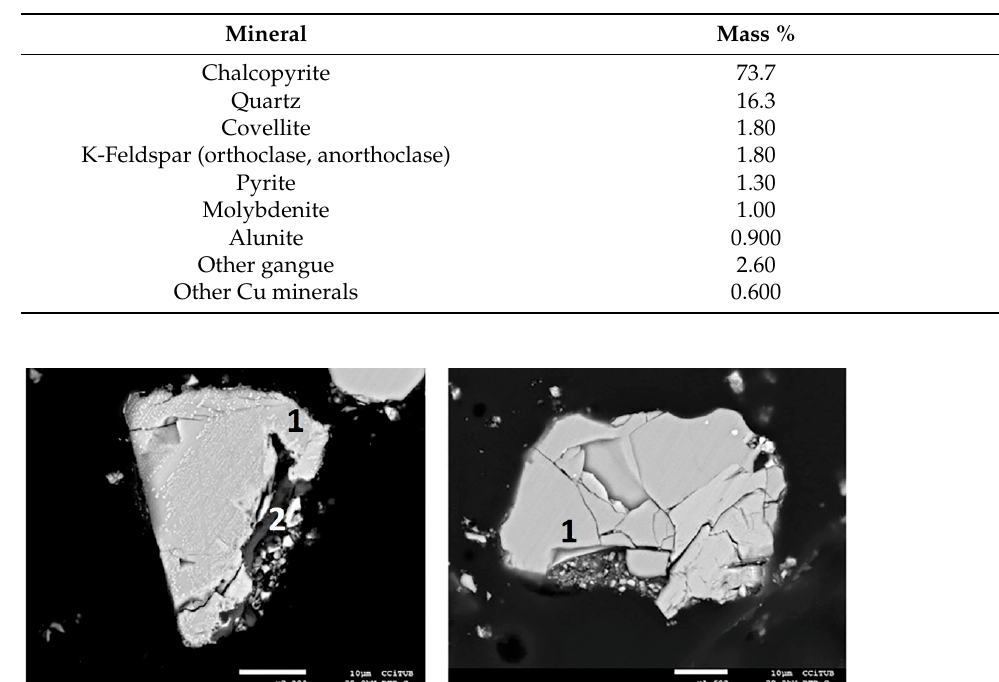
Figure 3. X-ray diffraction pattern of the initial sample [36]. Table 2. Main minerals in the chalcopyrite ore (mass in %) based on Qemscan analysis [36].